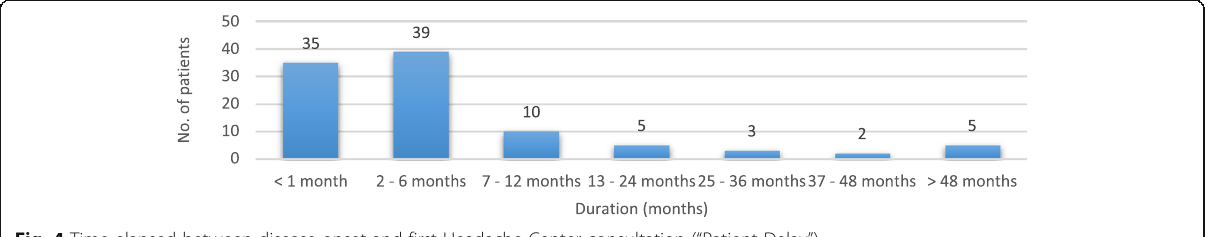
Fig. 4 Time elapsed between disease onset and first Headache Center consultation ( “ Patient Delay ” )